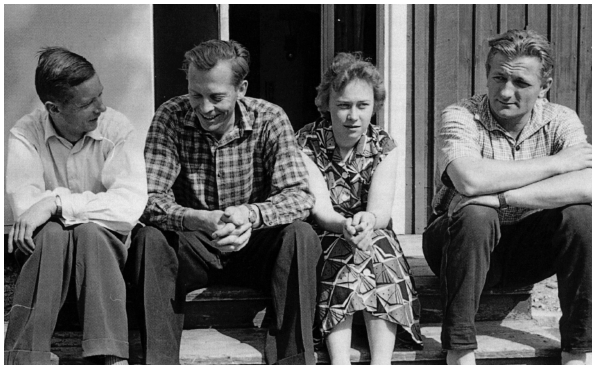
Figure 7. Hans-Georg Möller, Juhani Oksman, Mirja Martin (Hämäläinen), and Tarmo Mustonen in front of the ionospheric sta- tion (photo provided by Juhani Oksman).